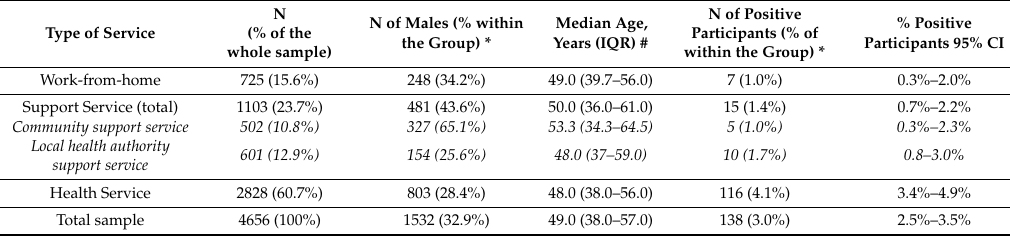
Table 1. The median age of the sample was 49 years (IQR 38–57), and males represented 32.9% of the sample. A total of 138 (2.96%) participants tested positive for SARS-CoV-2 antibodies. No age or sex di ff erences were found in the seroprevalence of antibodies against SARS-CoV-2 at univariate analysis. Table 1. Demographic characteristics and SARS-CoV-2 seroprevalence of the study population. Type of